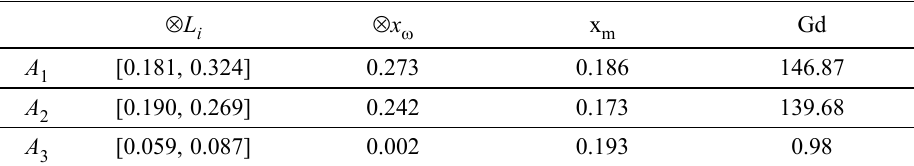
Table 11. The width and grey degree of overall grey performance ratings ⊗ L ⊗ x w x m Gd i [0.181, 0.324] 0.273 0.186 146.87 A 1 [0.190, 0.269] 0.242 0.173 139.68 A 2 [0.059, 0.087] 0.002 0.193 0.98 A 3